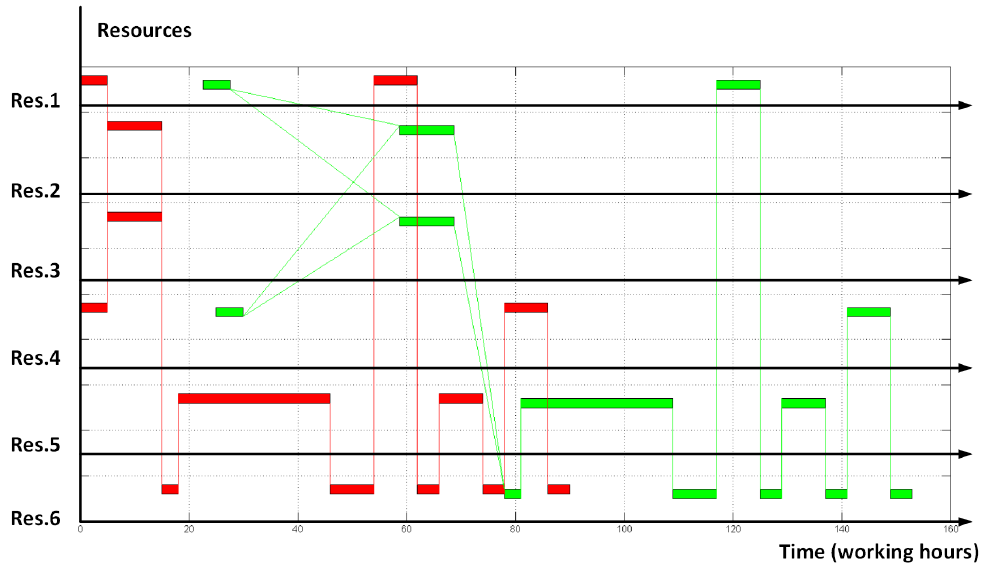
Figure 7. Branch-and-bound optimization result.